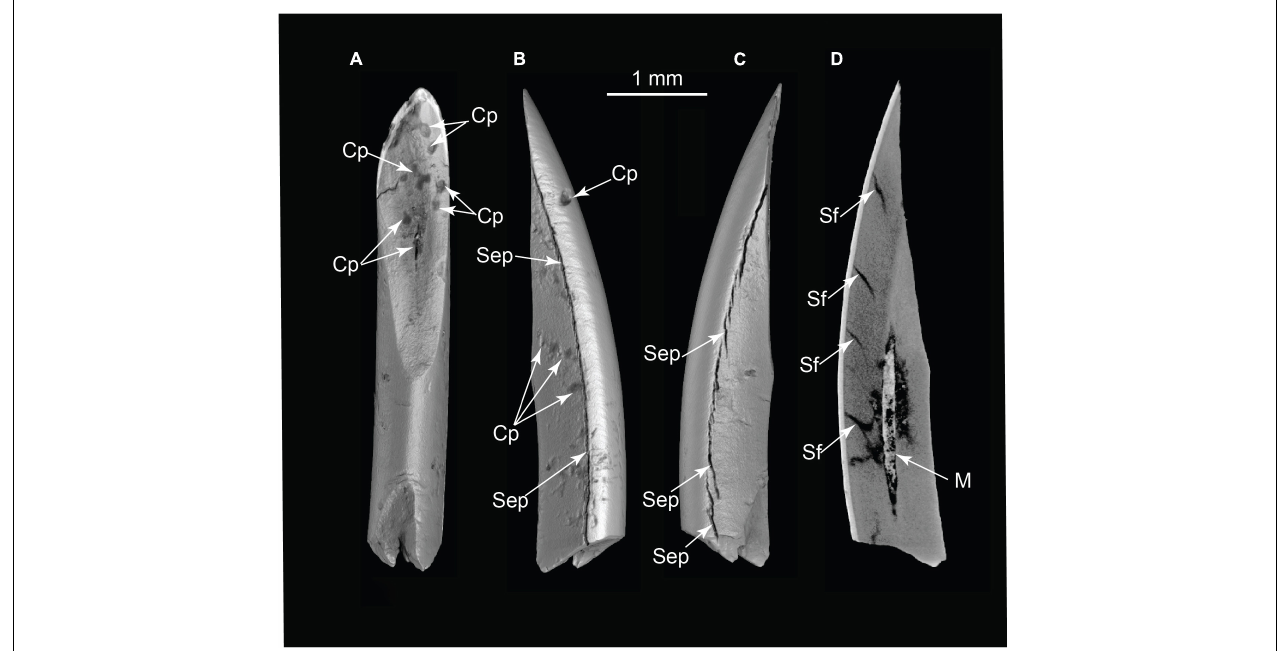
FIGURE 11 | Pyrogenic modifications to rodent incisor (volumetric reconstructions from µ CT). (A) Occlusal view; (B) medial or lateral view; and (C) medial or lateral view; (D ) CT slice revealing separation fractures and infilling of pulp cavity by ash. Cp, combustion pits; M, matrix in pulp cavity; Sep, separation by differential shrinkage at enamel-dentin junction; Sf, dentin shrinkage fractures in cross-section (TMM